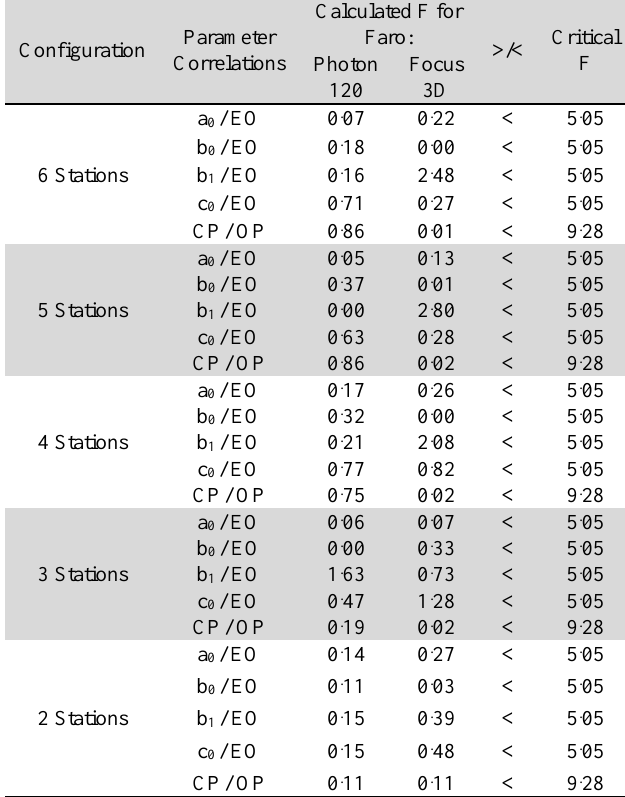
Table 2. F-variance ratio test for different